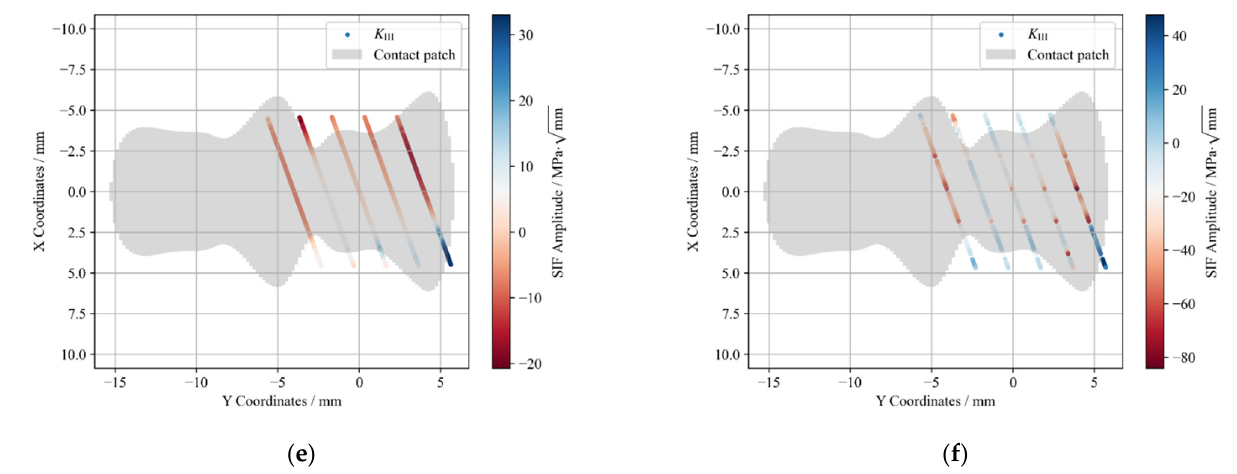
Figure 11. Results of SIFs at the straight line: ( a ) SIF of type I cracks without the grinding marks; ( b ) SIF of type I cracks with the grinding marks; ( c ) SIF of type II cracks without the grinding marks; ( d ) SIF of type II cracks with the grinding marks; ( e ) SIF of type III cracks without the grinding marks; ( f ) SIF of type III cracks with the grinding marks.